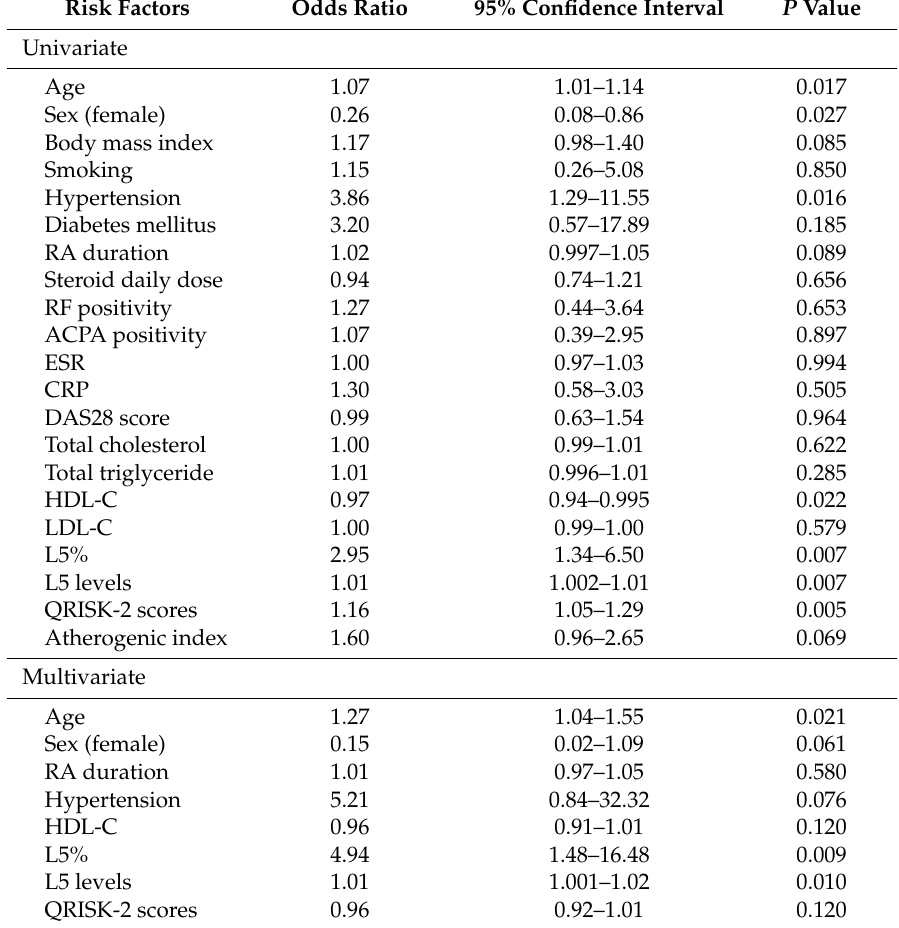
Table 3. Logistic association of traditional cardiovascular risk factors, RA-related factors, plasma L5% and L5 levels with the presence of subclinical atherosclerosis in RA